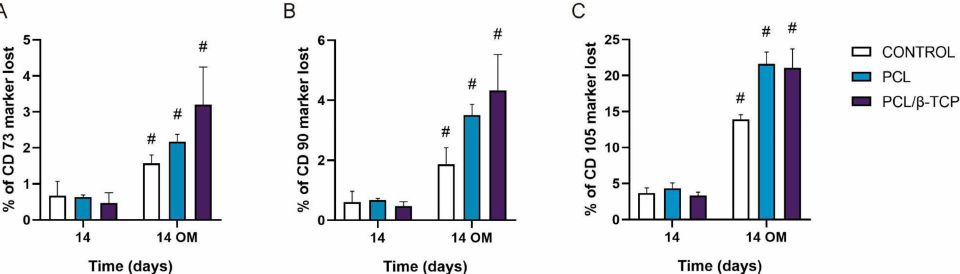
Figure 9. ( A ) CD73, ( B ) CD90, and ( C ) CD105 expressions of the cells seeded on PCL and PCL/ β -TCP scaffolds. Data represent the percentage of marker loss at 14 days with different culture medium (GM and OM). The experiment was performed in triplicate. # Significant differences between the marked group with different culture